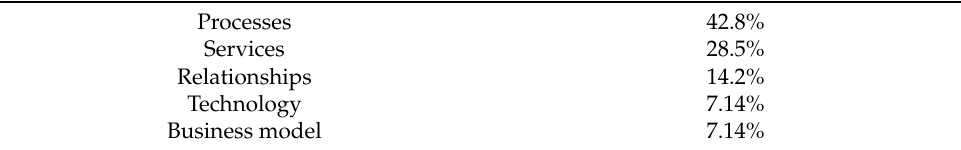
Table 2. Dimensions for digital